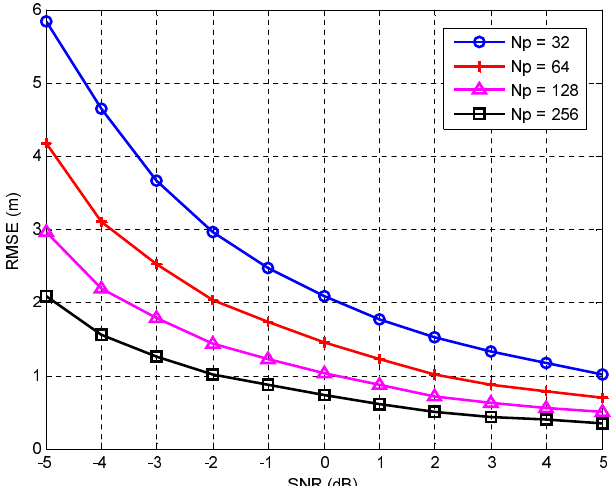
Figure 7. Performance of proposed algorithm for N p = 32, 64, 128, and 256. RMSE: root-mean-square error; SNR: signal-to-noise